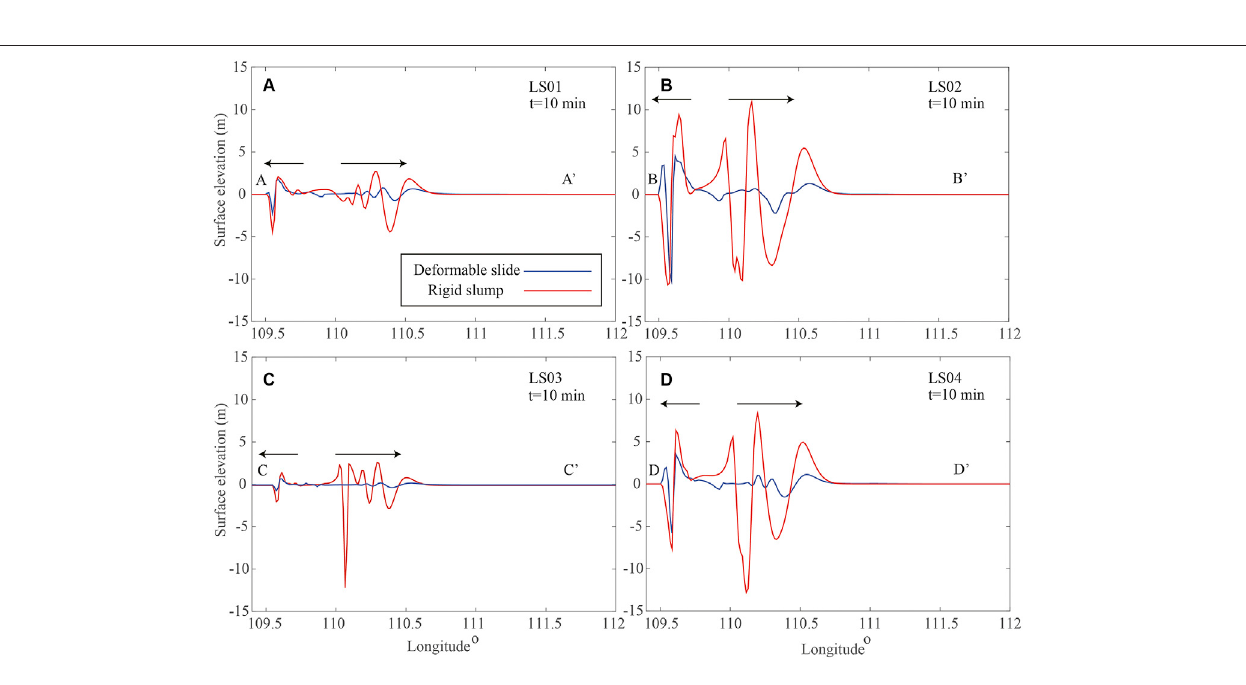
Frontiers in Earth Science |